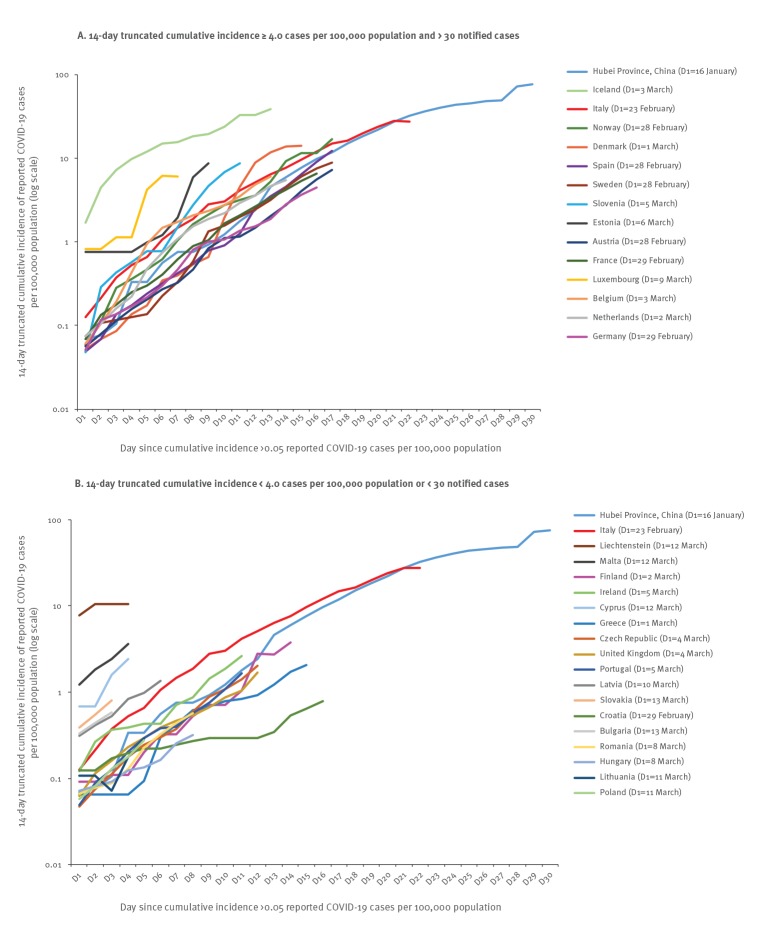
Time distribution of the 14-day truncated cumulative incidence of COVID-19 for (A) 14-day truncated cumulative incidence ≥ 4.0 cases per 100,000 population and > 30 notified casesa and (B) 14-day truncated cumulative incidence < 4.0 cases per 100,000 population or < 30 notified casesb, EU/EEA countriesand the UKc, 15 March 2020